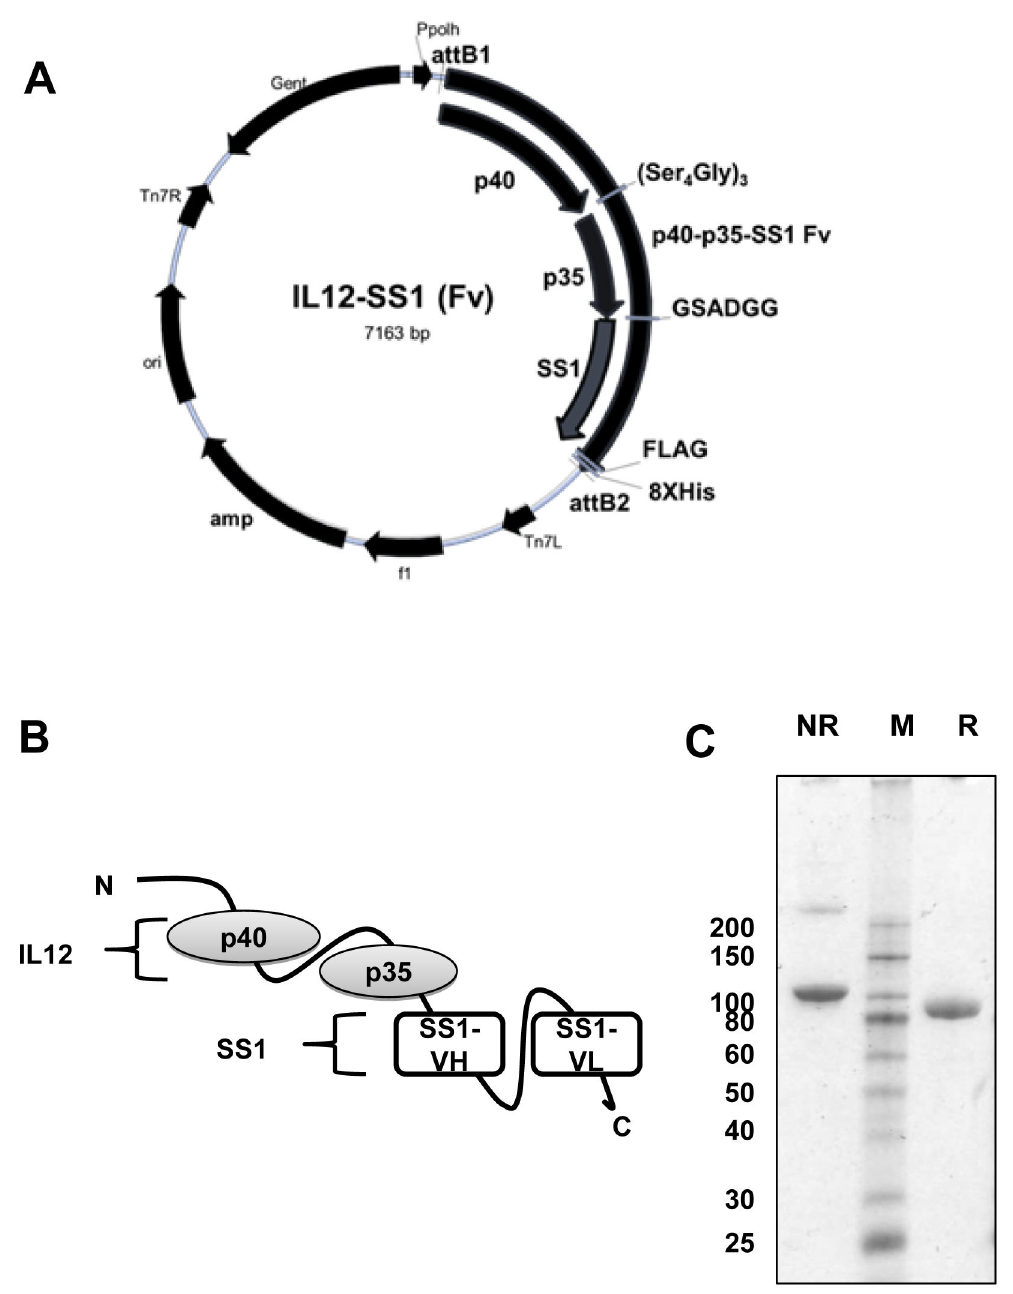
Figure 1. Construction of IL12-SS1 (Fv) fusion protein. (A) The map of the baculovirus expression vector. IL12-SS1 (Fv) was inserted at the recombination sites attB1 and attB2 using the gateway cloning system. (B) Cloning strategy and schematic representation of the IL12-SS1 (Fv) fusion protein. The IL12-SS1 (Fv) fusion protein consists of p40 and p35 fused to scFv (SS1). (C) SDS-PAGE analysis of 5 µg of IL12-SS1 (Fv) protein under reducing (R) or non-reducing (NR) conditions confirms protein size. Analysis: SDS-PAGE, 4-20% gradient gel, Coomassie blue staining. M; protein standards, kDa. doi: 10.1371/journal.pone.0081919.g001 binding specificity of IL12-SS1 (Fv) for MSLN was examined by fusion protein as a negative control and found there was no ELISA (Fig. 2A). The recombinant IL12-SS1 (Fv) bound to binding to rFc (OD <=0.1) and no dose-dependent correlation MSLN in a dose-dependent manner. We used a rabbit Fc (rFc) with rFc binding (Fig. 2A). To determine whether the binding of